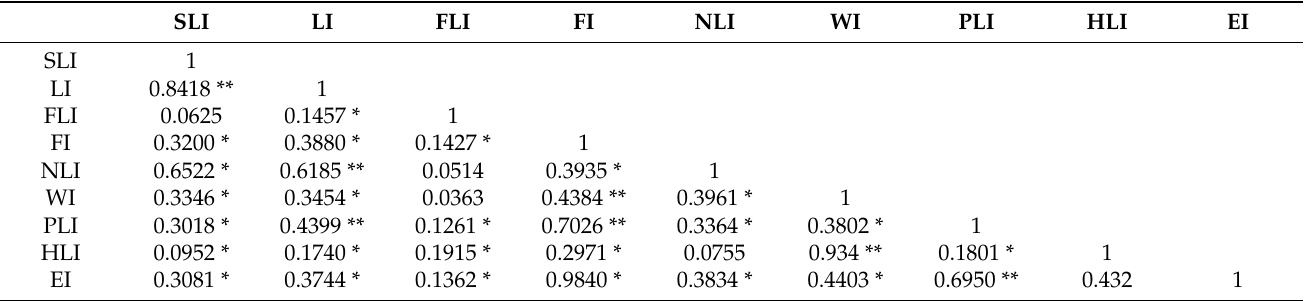
Table 6. Correlation matrix for the composite weight of LWEF nexus and Livelihood